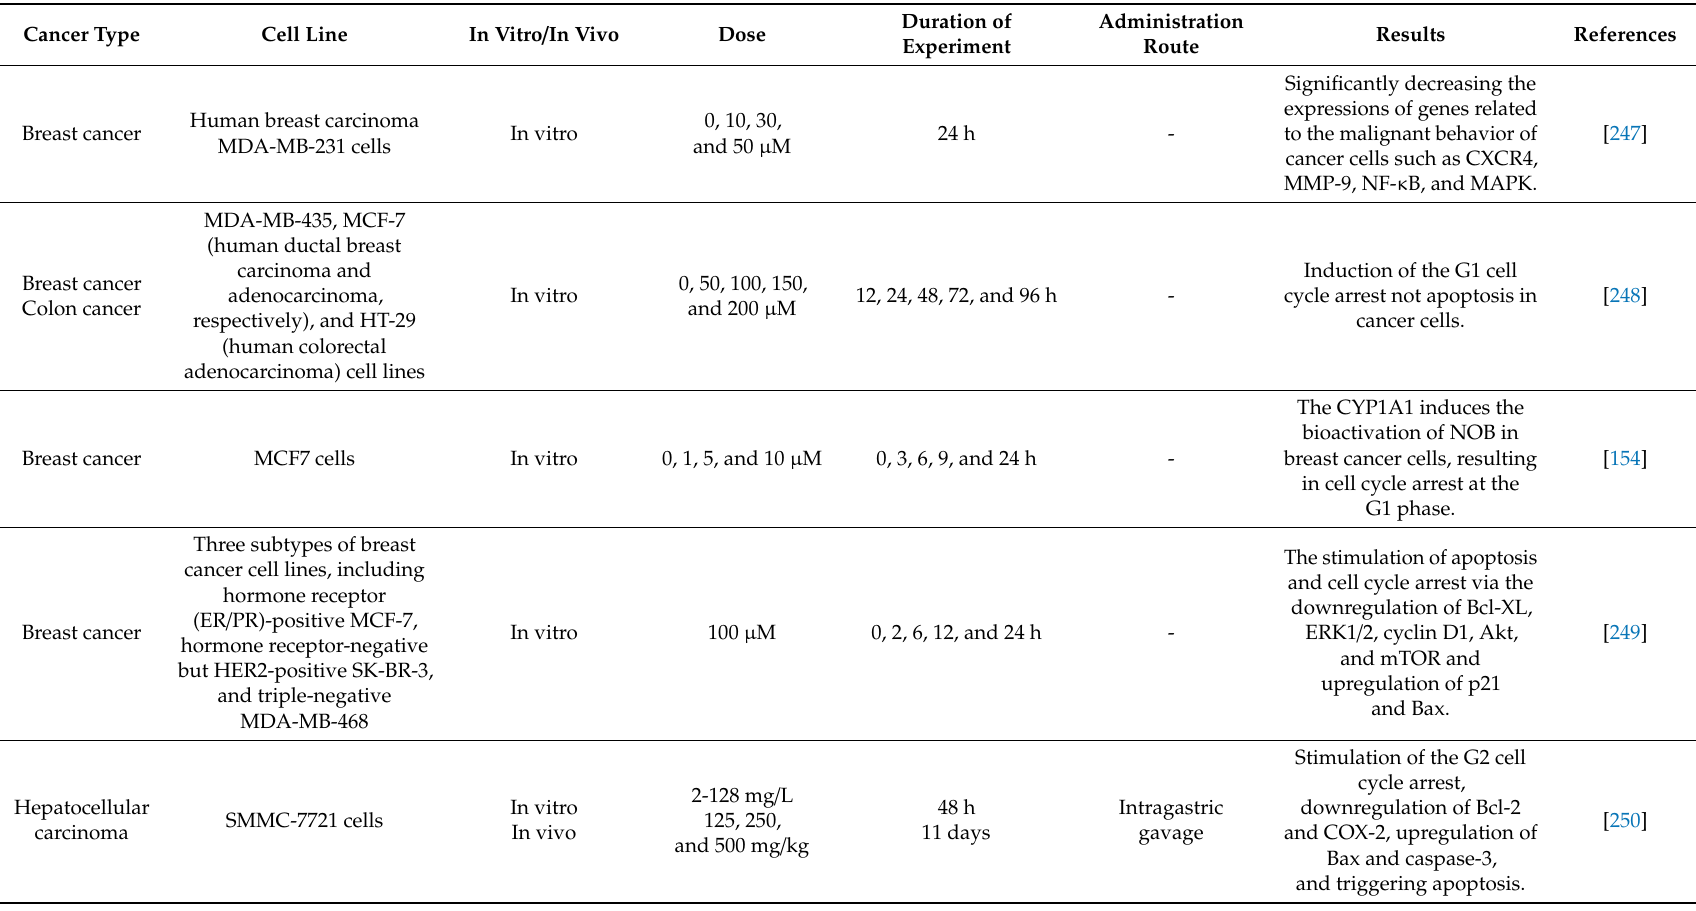
Table 2. The antitumor activity of nobiletin in di ff erent